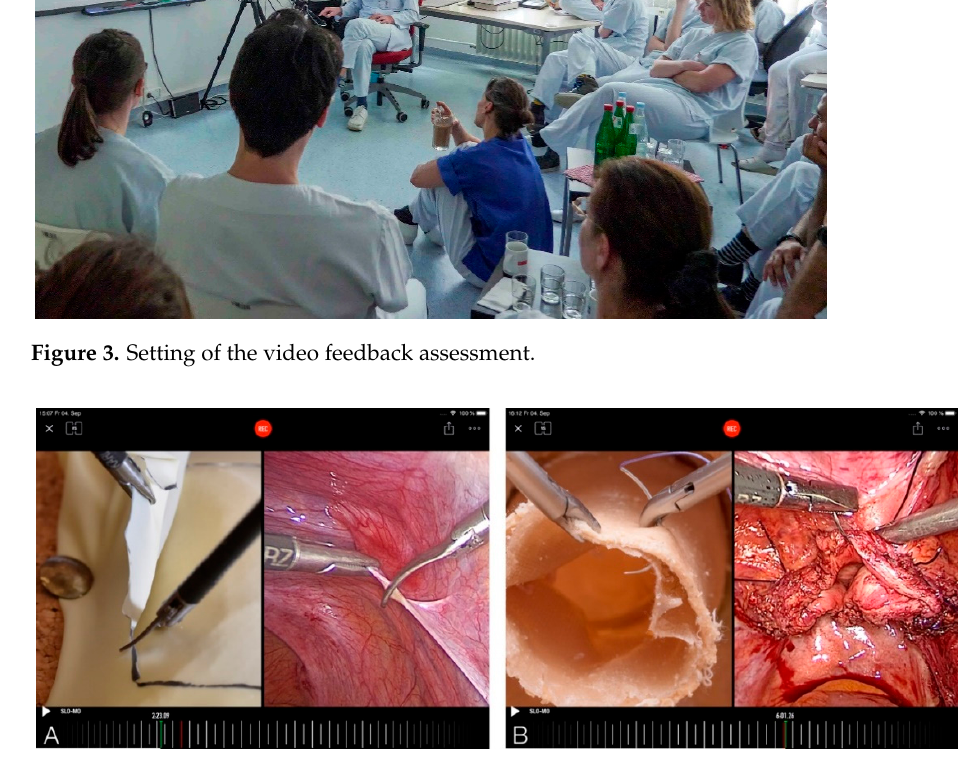
Figure 4. Video modeling of the resection task ( A ); video modeling of the vaginal vault closure task ( B ).